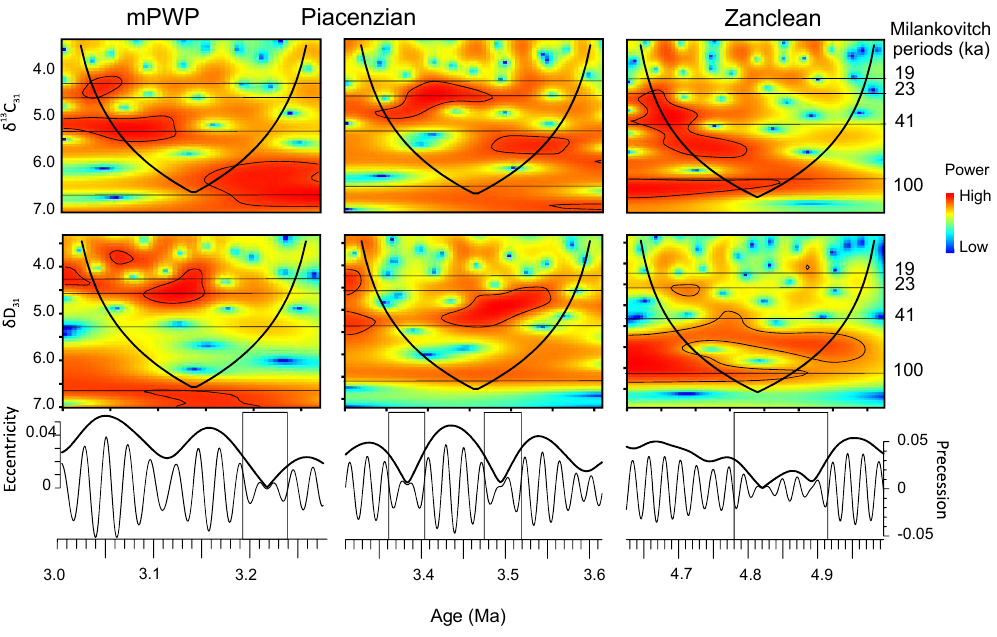
Figure 5. Spectral analysis of stable carbon ( δ 13 C 31 ) and hydrogen ( δ D 31 ) isotope compositions of the C 31 n alkane using a Morlet wavelet for three periods of the Pliocene (4.995–4.625, 3.615–3.310, and 3.270–3.005Ma). Data are interpolated to 5kyr steps. Signal power is expressed in colour shadings with the significance level ( p = 0 . 05) in black contours. The cone of influence (thick black line) identifies the area of boundary effects. Periodicities per thousand years on the vertical axes (log 2 scale). Horizontal lines denote orbital periodicities of 19 and 23kyr (precession), 41kyr (obliquity), and 100kyr. Bottom: eccentricity and precession for the same periods based on Lascar et al. (2004) http://vo.imcce.fr/insola/earth/online/earth/online/. Boxes indicate periods with reduced eccentricity and low precession